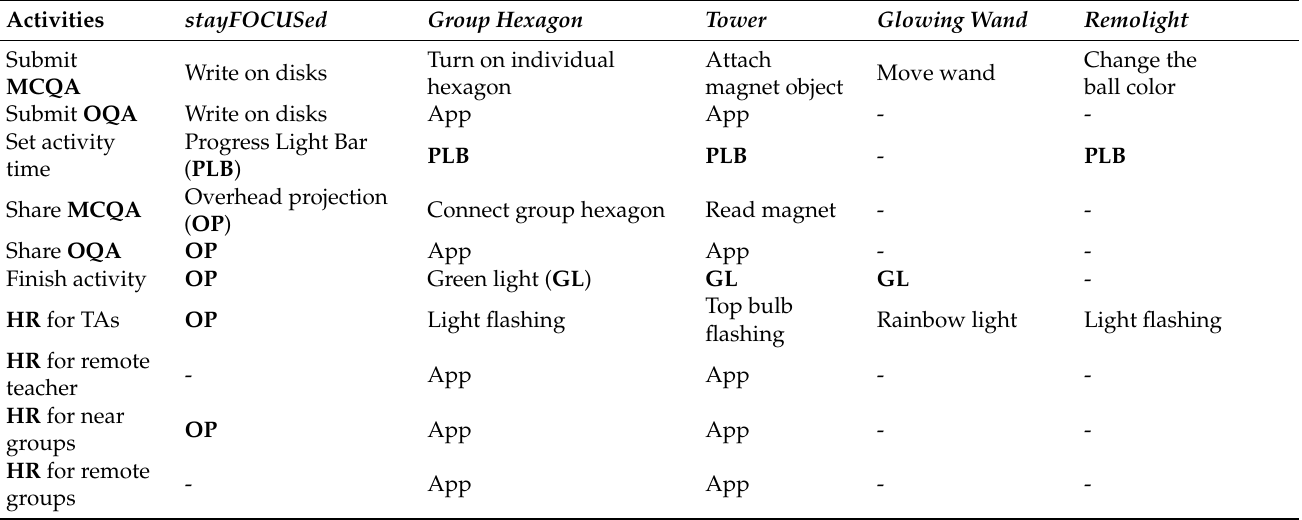
Table 3. Collaborative learning activities supported in our paper ( MCQA : Multiple Choice Question Answer; OQA : Open Question Answer; HR : Help Request; TA : Teaching